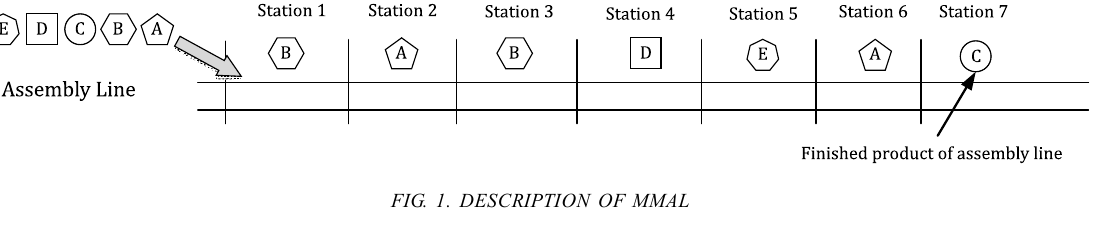
TABLE 1. PROCESS TIME OF MODELS ON RESPECTIVE WORK